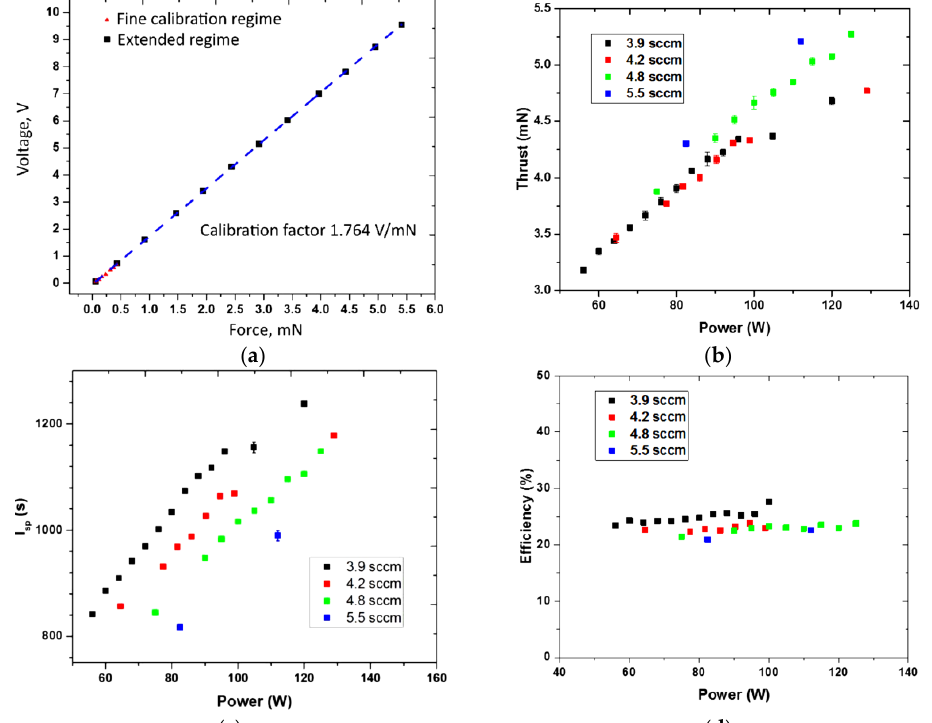
Figure 4. Thrust measurements results: ( a ) calibration curve; and operational parameters for a Kr-fed low-power Hall thruster: ( b ) thrust; ( c ) specific impulse; ( d ) thrust efficiency. © [2018] IEEE. low-power Hall thruster: ( b ) thrust; ( c ) specific impulse; ( d ) thrust e ffi ciency. © [2018] IEEE. Reprinted, with permission, from Lim et al., IEEE Transactions on Plasma Science 46, 2 (2018) [22].